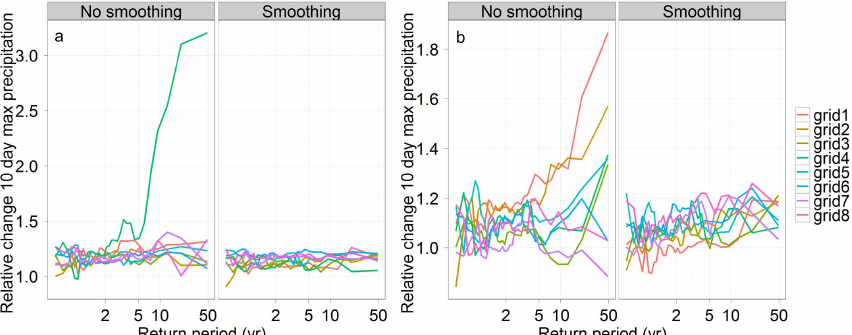
Fig. 2. Relative changes of the return levels of 10-day precipitation in the winter half-year (October–March) for each of the eight GCM grid cells covering the Rhine basin. Panel (a) : results for the CGCM3.1T63 simulation; panel (b) : results for the ECHAM5r1 simulation. Within both panels, the left part shows the results for no temporal and spatial smoothing and the right part shows the results with smoothing. Note the difference in plotting scale for the CGCM3.1T63 and ECHAM5r1